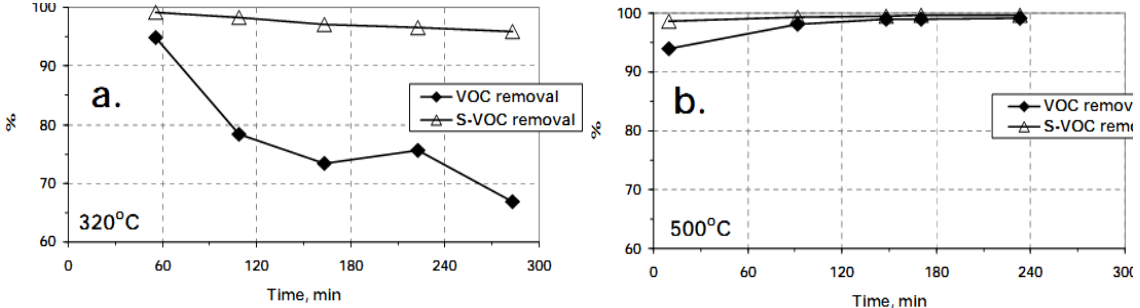
Figure 17. Efficiency of VOC and S-VOC removal on 0.9 wt.% Au/HZSM-5: long-term test at 320 and 500 °C. Reaction conditions: reactant mixture 1100 ppm CH ppm of (CH S) + air; 75 200 h − 1 . Reproduced with permission from [53]. Copyright 2007 3 2 Elsevier